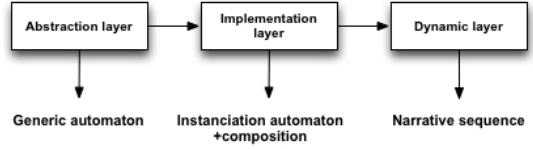
Figure 3. The three layers